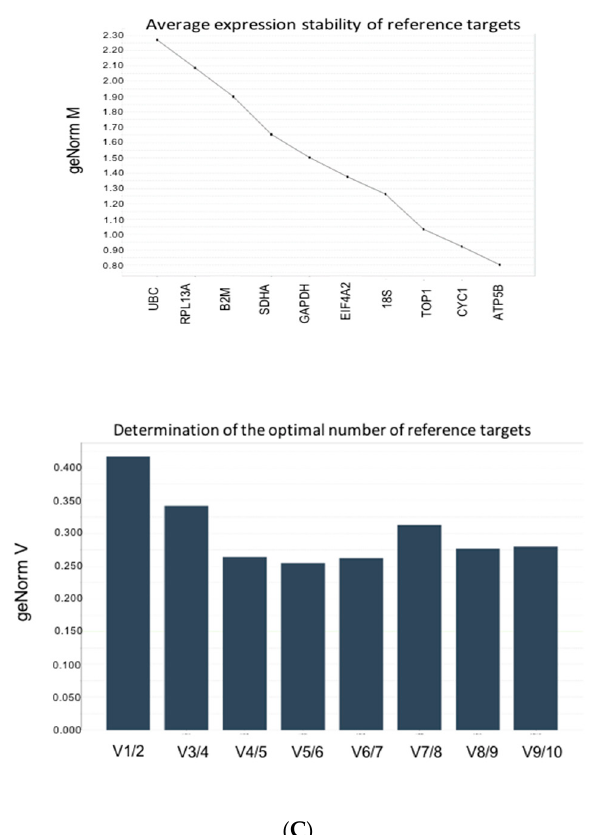
Figure 2. Optimal reference target selection. ( A ) M and V values for CPZ-treated and untreated cells. M and V values for CPZ-treated and untreated cells. The optimal number of reference targets in this experimental situation is 3 (geNorm V < 0.15 when comparing a normalization factor based on the 2 or 3 most stable targets). As such, the optimal normalization factor can be calculated as the geometric mean of reference targets GAPDH, UBC, and TOP1. ( B ) M and V values for APAP -treated and untreated cells. M and V values for APAP-treated and untreated cells. The optimal number of reference targets in this experimental setting is 3 (geNorm V < 0.15 when comparing a normalization factor based on the 2 or 3 most stable targets). As such, the optimal normalization factor can be calculated as the geometric mean of reference targets ATP5B, SDHA, and CYC1. ( C ) M and V values for combined CPZ- and APAP-treated and untreated cells. M and V values for combined CPZ- and APAP-treated and untreated cells. No optimal number of reference targets could be determined, as the variability between sequential normalization factors is relatively high (geNorm V > 0.15). Therefore, the optimal number of reference targets in this experimental setting is 5. As such, the optimal normalization factor can be calculated as the geometric mean of reference targets with the lowest M value (ATP5B, CYC1, TOP1, 18s, and EIF4A1).